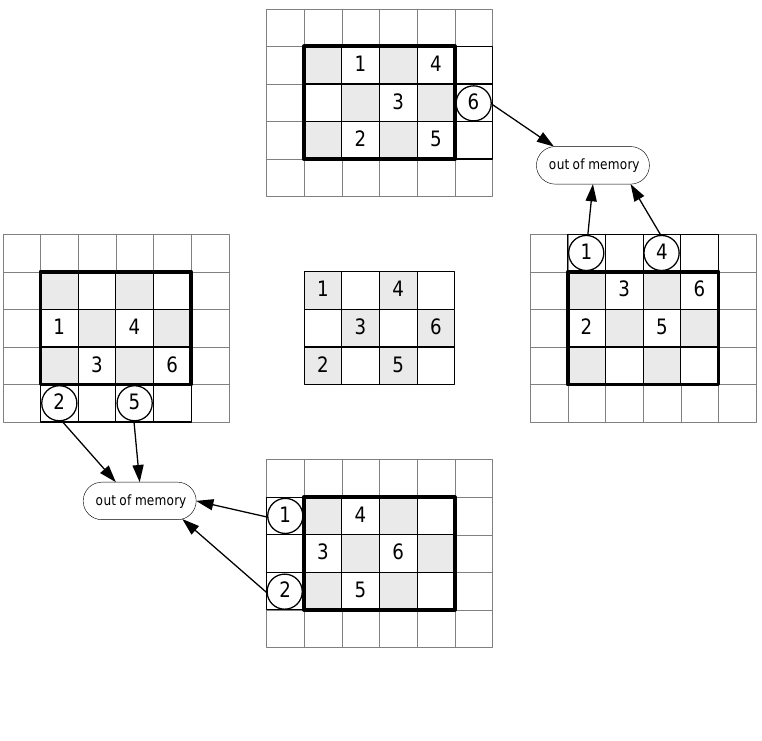
Figure 4. Memory addressing for odd